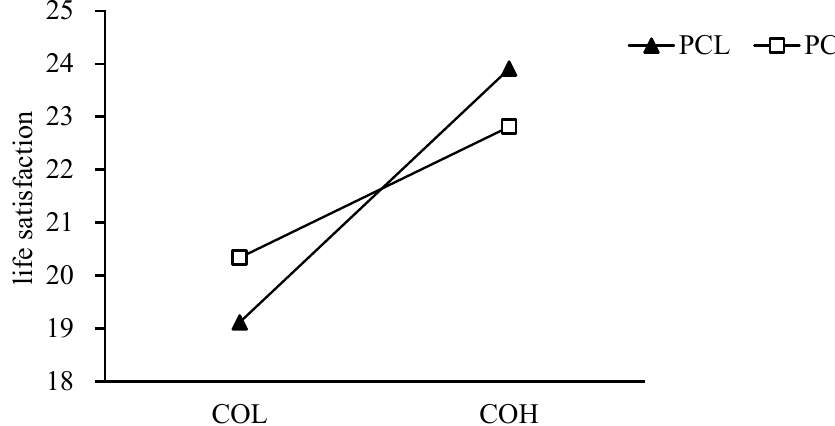
Figure 3. The moderating effect of perfectionistic concerns on the relationship between perceived control and life satisfaction. COL: low perceived control, NH: high low perceived control, PSL: low perfectionistic concerns, PSH: high perfectionistic concerns.